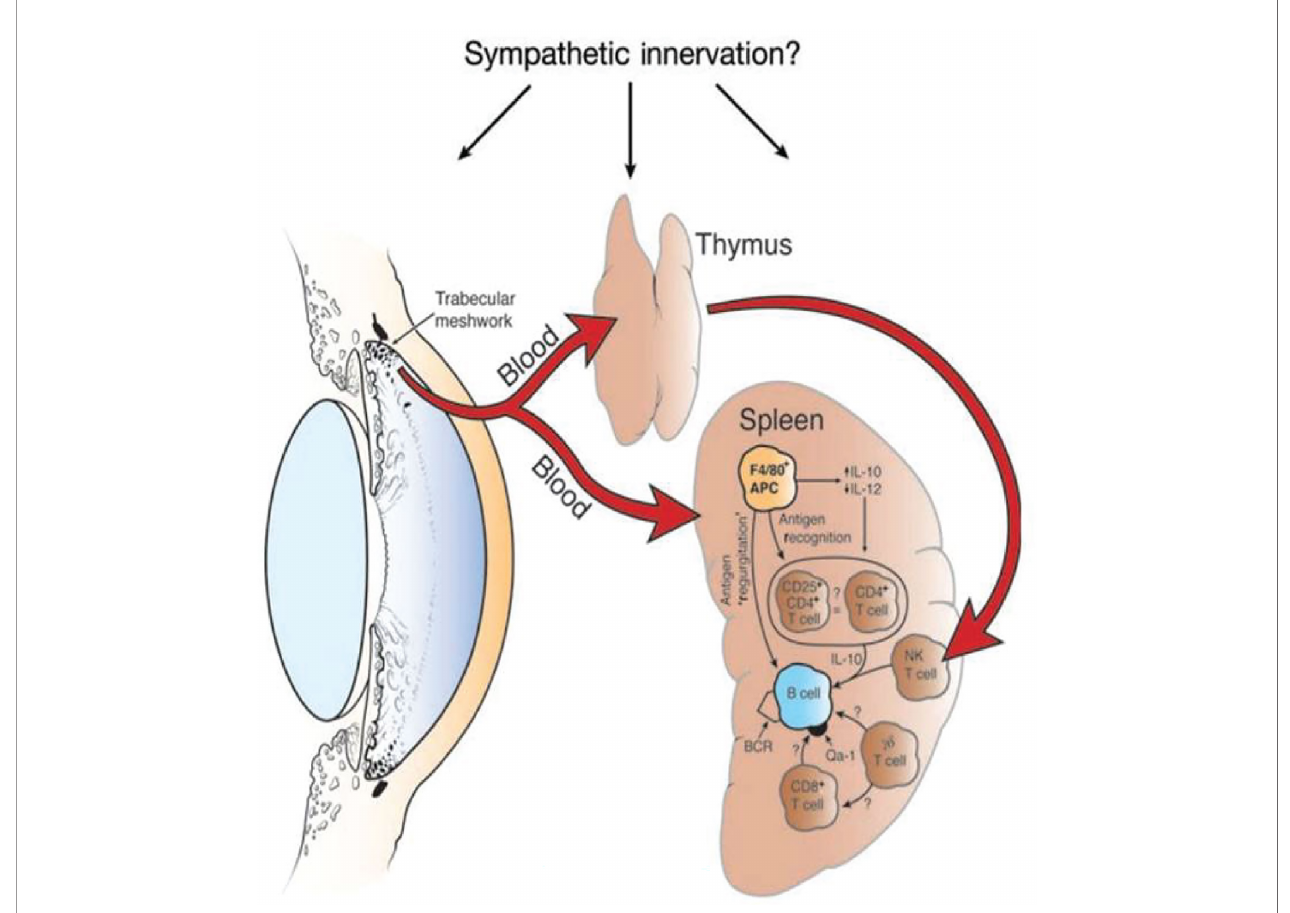
FIGURE 2 | Four organ systems are required for the induction of ACAID. Removal of the eye, spleen, or thymus within 3 days of injecting antigen into the anterior chamber prevents the induction of ACAIDS. Chemical sympathectomy prior to injecting antigens into the anterior chamber also prevents ACAID. BCR, B cell receptor. Reproduced from Niederkorn (9) with permission from Nature Publishing